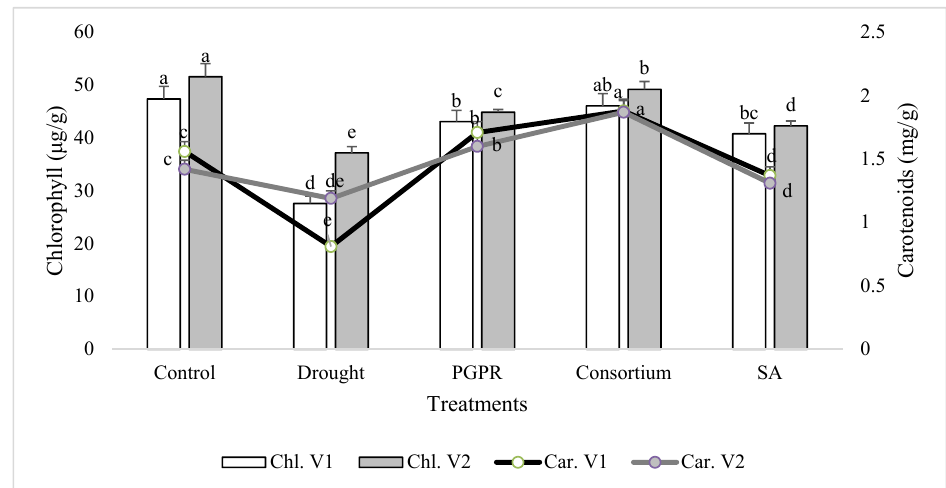
Figure 1. Leaf chlorophyll and carotenoids contents of drought sensitive (V1) and tolerant varieties (V2) grown under rainfed conditions. PGPR: Planomicrobium chinense and Bacillus cereus ; SA: salicylic acid. Chl: chlorophyll; Car: carotenoids. Different significance levels were denoted with different letters (a, b, c, d and e).